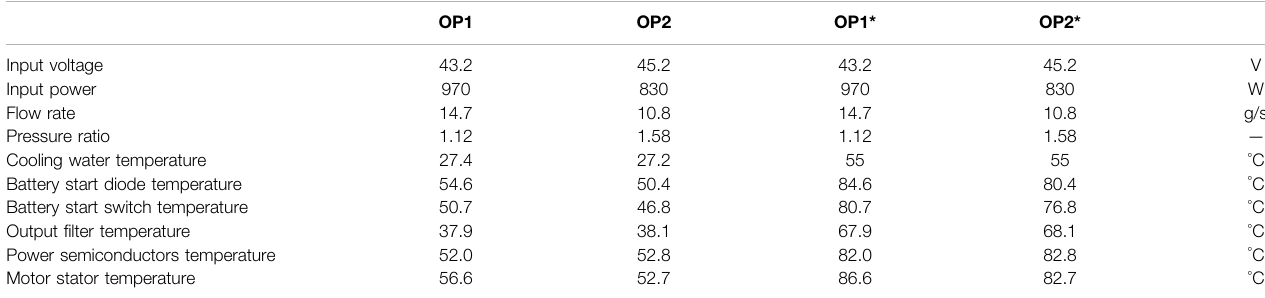
TABLE 4 | Temperature measurements of critical parts of compressor with integrated inverter (for maximum power (OP1) and maximum pressure ratio (OP2) according to Figure 11 ) and linear extrapolation to operating points with higher coolant temperature of 55 ° C (OP1* and OP2*) complying with the temperature limit of 90 ° C for the critical